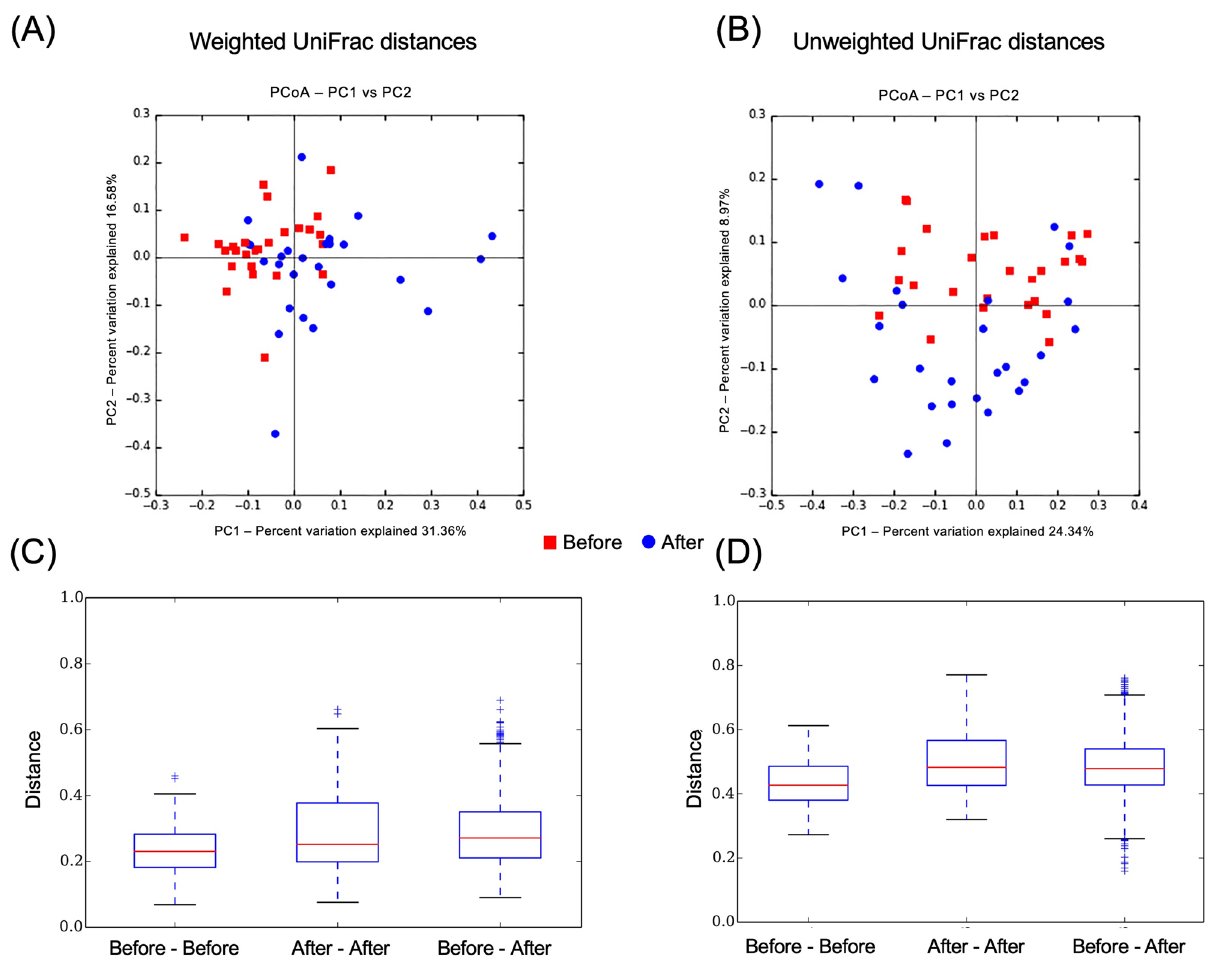
Figure 7. Principal coordinates analysis revealed clustered communities of gut microbiota after eradication in the before and after eradication therapy groups. ( A ) Weighted UniFrac distances, ( B ) Unweighted UniFrac distances. Bar diagram showing the Mean UniFrac distances for Before–Before, After–After, and Before–After participants. ( C ) Weighted UniFrac distances (Before–Before vs. Before–After, P = 0.03; After–After vs. Before– After, P = 1.00), ( D ) Unweighted UniFrac distances (Before–Before vs. Before–After, P = 0.03; After–After vs. Before–After, P =